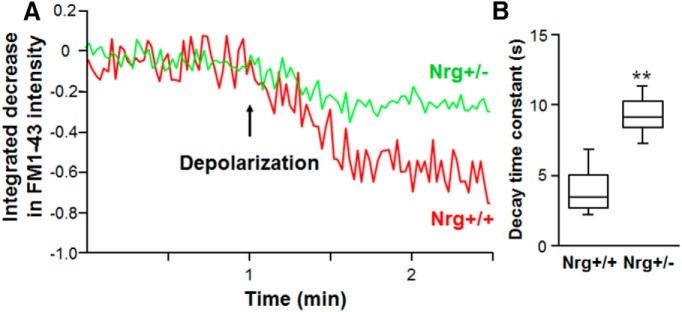
Reduced presynaptic type III Nrg1 slows depolarization-induced FM1-43 release. A, Spinning disk confocal images of FM1-43-loaded axons from either +/+ or +/− vHipp were collected every 1.5 s for 5 min, and FM1-43 fluorescence intensities were calculated and quantified as a normalized integrated intensity at each time point. The percentage decrease of normalized integrated intensity at an individual 1-µm spot (3 pixels) along vHipp axons were plotted versus time. Representative plots of the release time course from Nrg+/+ (red) and Nrg+/− (green) vHipp axon are shown before and after depolarization. B, Box plot of pooled data shows slower decay time constant (τ) of high K+ depolarization-induced FM1-43 destaining along axons from Nrg+/− (∼8.5 s, n = 20, 8) compared with Nrg+/+ (∼4.8 s, n = 36, 10 experiments; **p < 0.01).